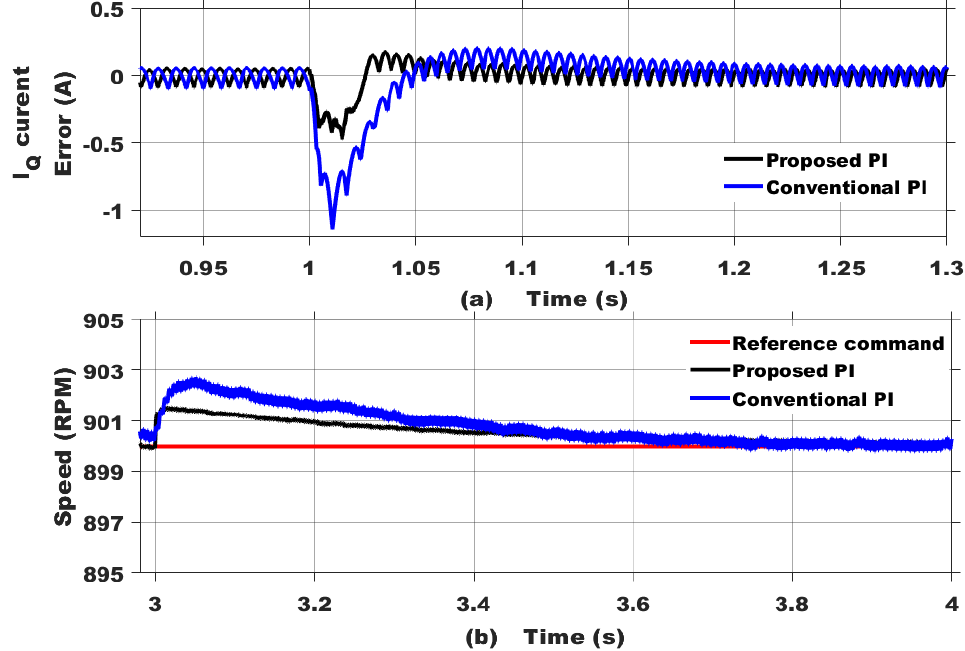
Figure 13. Comparison of robust regulatory performance of SynRM drive under the parametric variations: ( a ) current regulation under L d and L q variation, ( b ) speed regulation under iron losses variation.